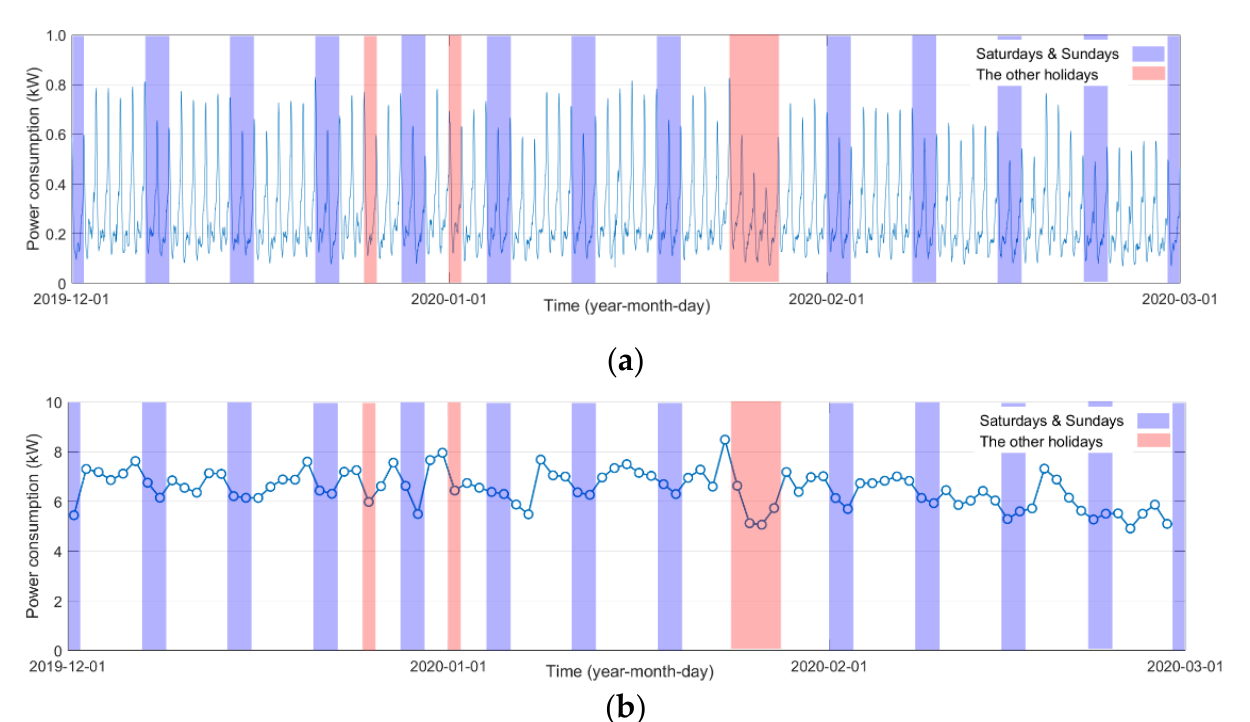
Figure 2. Periodicity analysis result of Electric Vehicle Charging (EVC) demand data: ( a ) 15-minutely average, ( b ) daily average.